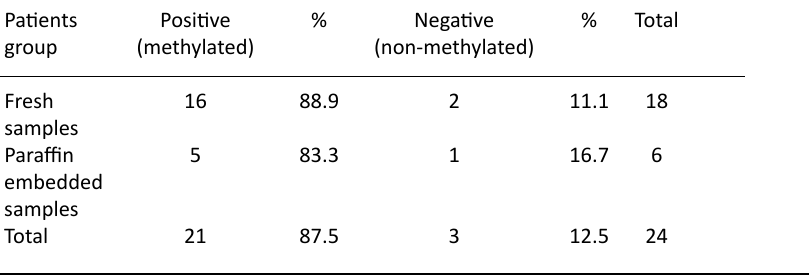
Table 5. Methylation status in EBV associated gastric carcinoma